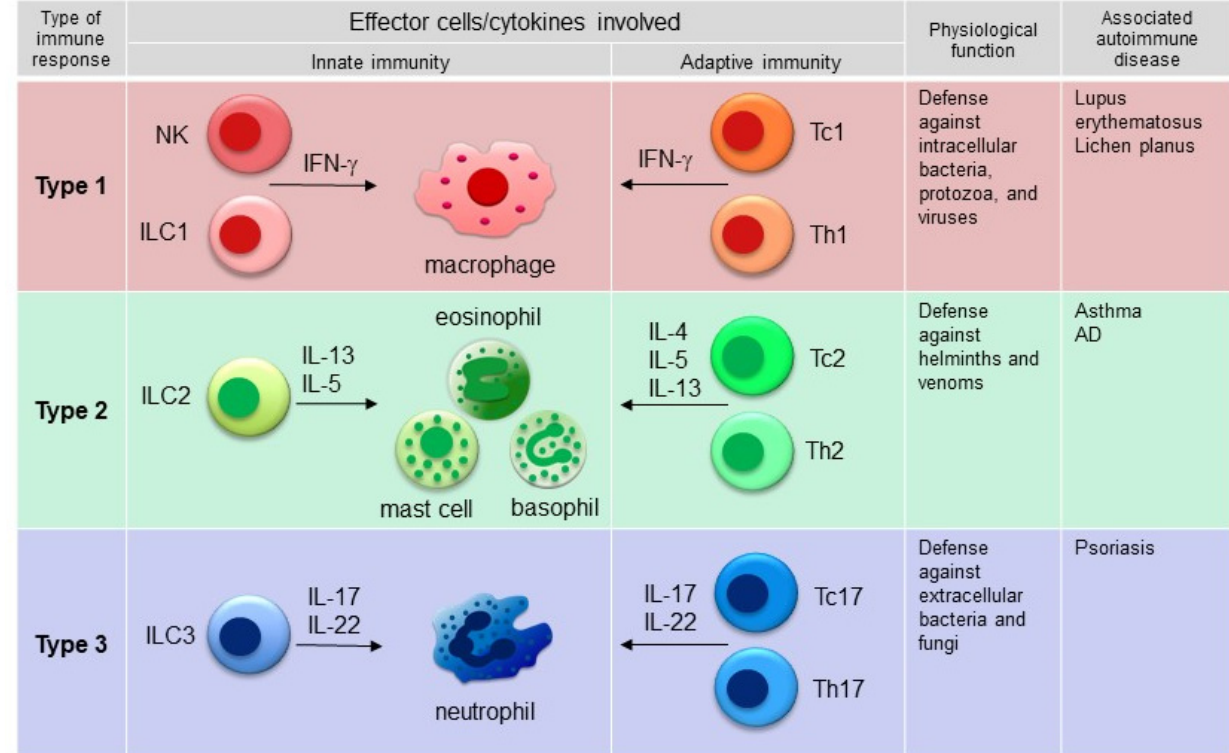
Figure 1. Three major types of immune response pattern and related autoimmune diseases. Type